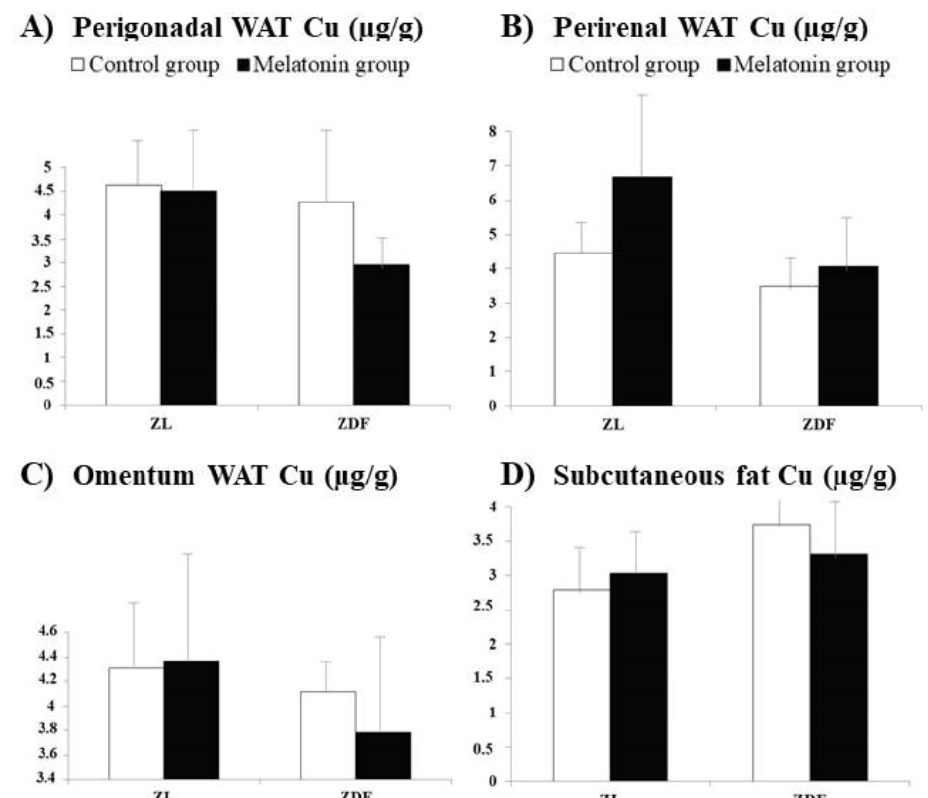
Figure 4. Influence of melatonin supplementation in Cu levels of different white adipose tissues (WAT) in male Zücker lean and diabetic fatty rats. ( A ) Gonadal WAT Cu. ( B ) Renal WAT Cu. ( C ) Omentum WAT Cu. ( D ) Subcutaneous Cun. C–ZL: Control lean rats without melatonin; M–ZL: Lean rats with melatonin; C–ZDF: Control diabetic fatty rats without melatonin; M–ZDF: Dia- betic fatty rats with melatonin; ZL: Zücker lean rats; ZDF: Zücker diabetic fatty rats. Values are means ± SEM ( n = 10) of ratios of Zn levels ( p > 0.05; Tukey post hoc